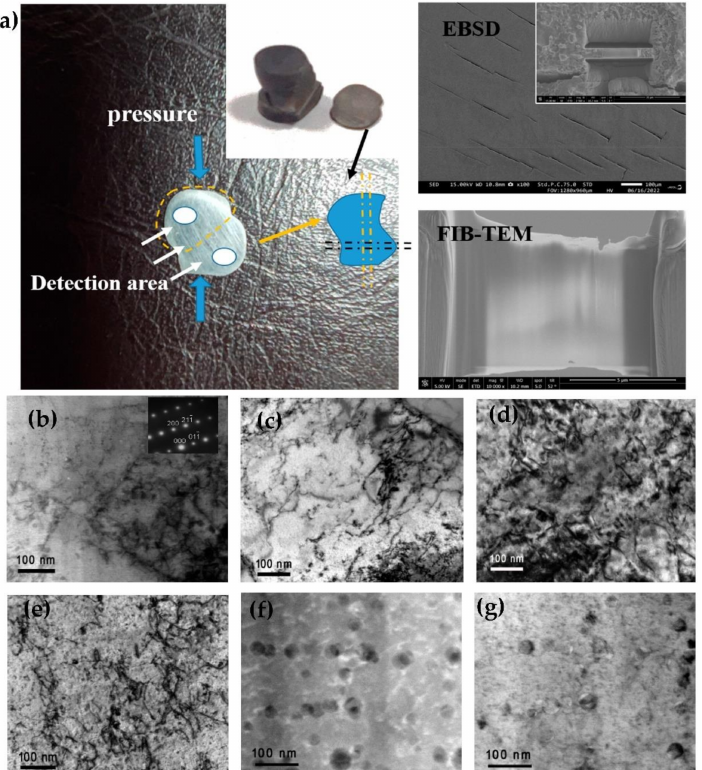
Figure 6. Microstructures of Mo 5 SiB 2 single crystals at different compression rates and temperatures: ( a ) sampling sites of TEM specimens prepared with the focused ion beam method (FIB), ( b ) 1200 ◦ C and 0.01 s − 1 , ( c ) 1200 ◦ C and 0.001 s − 1 , ( d ) 1300 ◦ C and 0.01 s − 1 , ( e ) 1300 ◦ C and 0.001 s − 1 , ( f ) 1400 ◦ C and 0.01 s − 1 , and ( g ) 1400 ◦ C and 0.001 s − 1 .